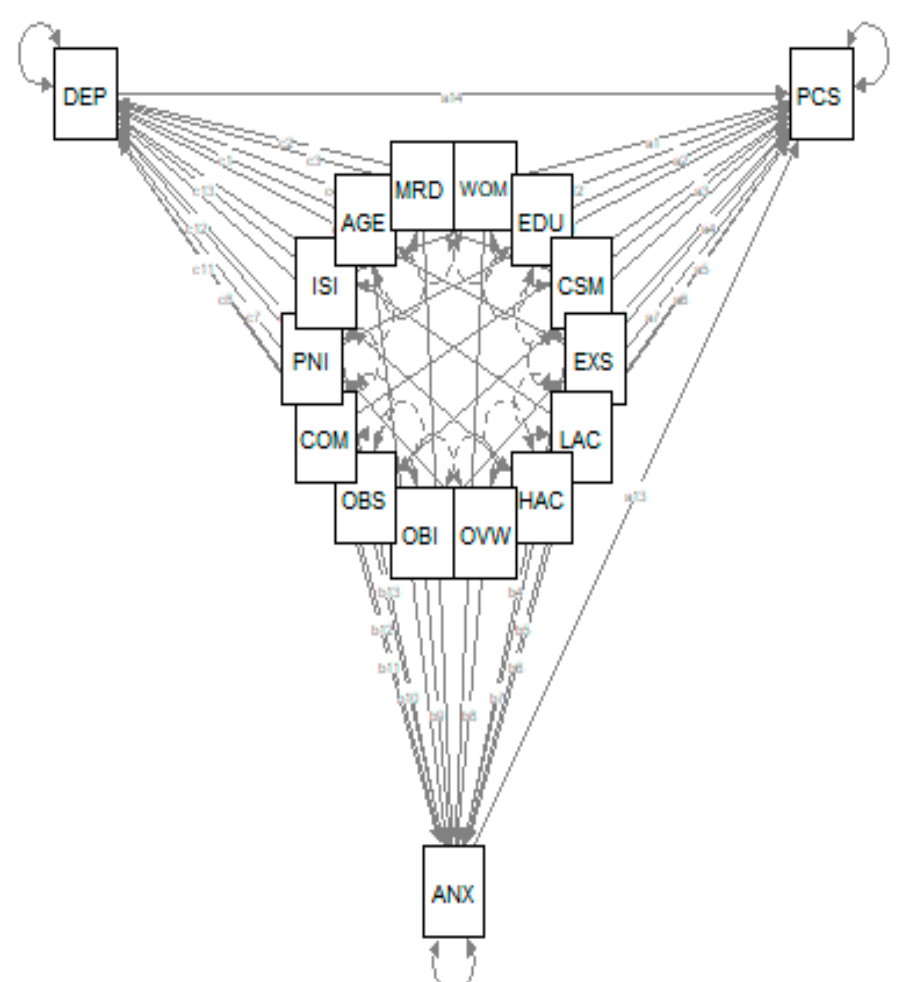
Figure 1. Theoretical model. PCS: Pain Catastrophizing Scale; ANX: anxiety as measured by General